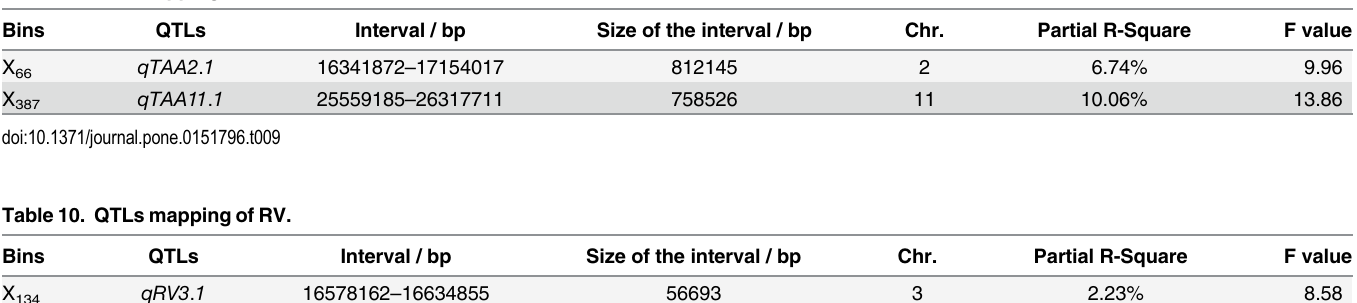
Table 9. QTLs mapping of TAA.